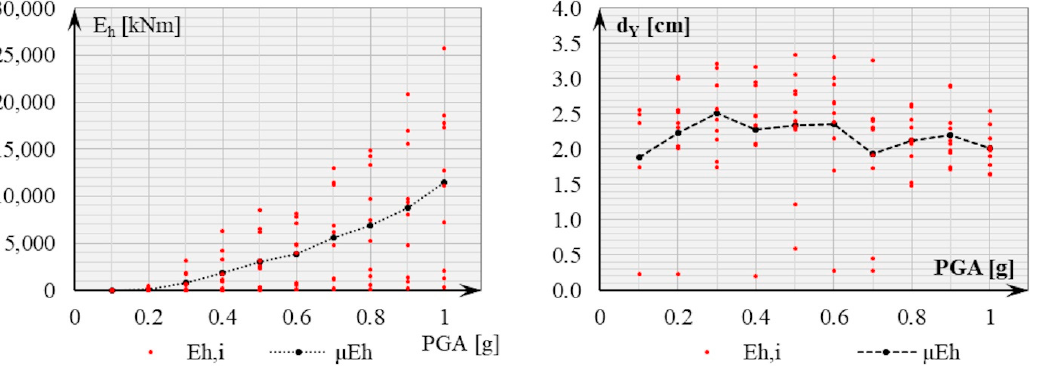
Figure 11. Absorbed hysteretic energy during the earthquakes ( left ) and the first yield displacement values from THA ( right ) obtained using NDA .